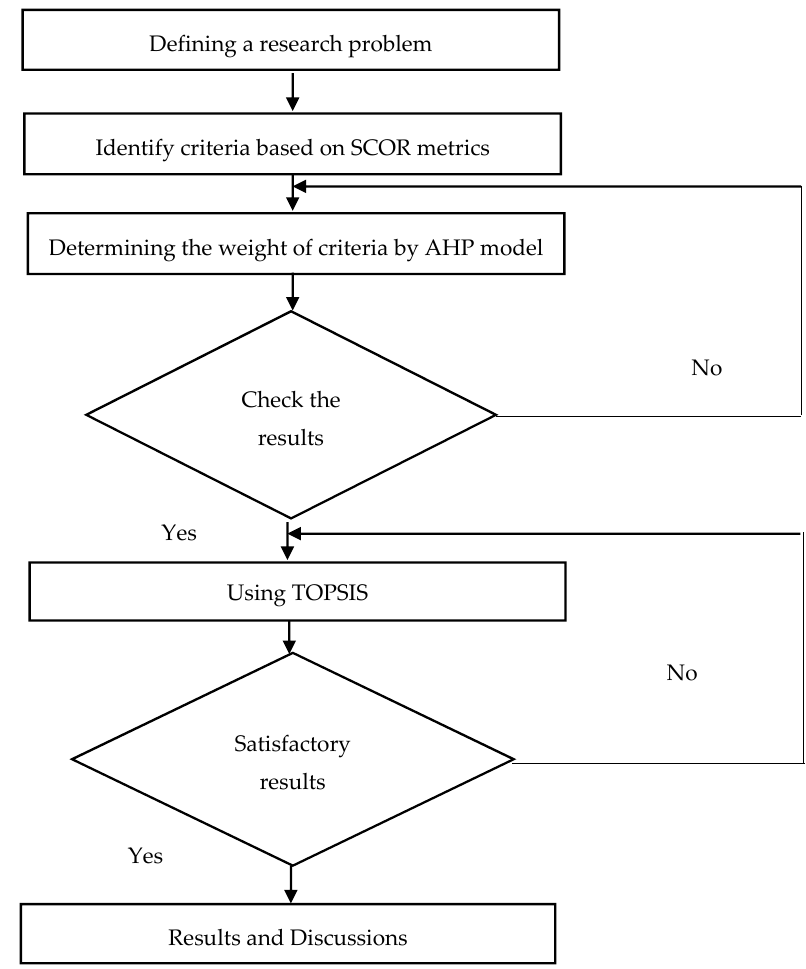
Figure 1. Research methodology (SCOR: Supply Chain Operations Reference metrics; AHP: Analytic Hierarchy Process; TOPSIS: Technique for Order of Preference by Similarity to Ideal Solution). Step 1: Defining objectives and criteria. In this step, the criteria for supplier evaluation and selection are identified. All the criteria were built through SCOR metrics and literature reviews.